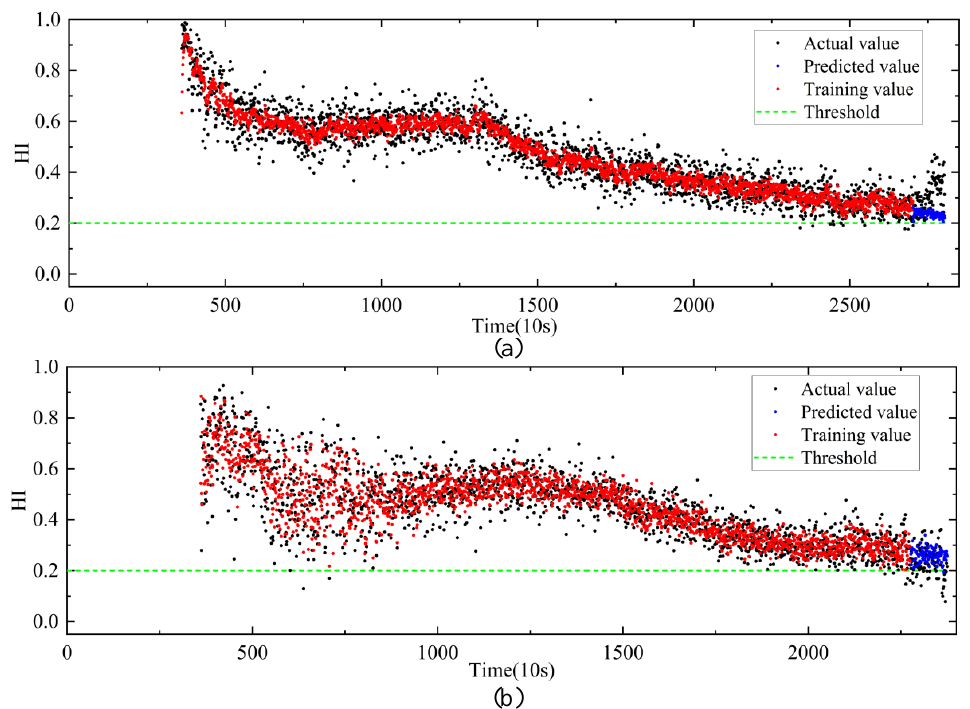
Figure 13. RUL prediction results of RCNN-HI. ( a ) Bearing1_1. ( b )